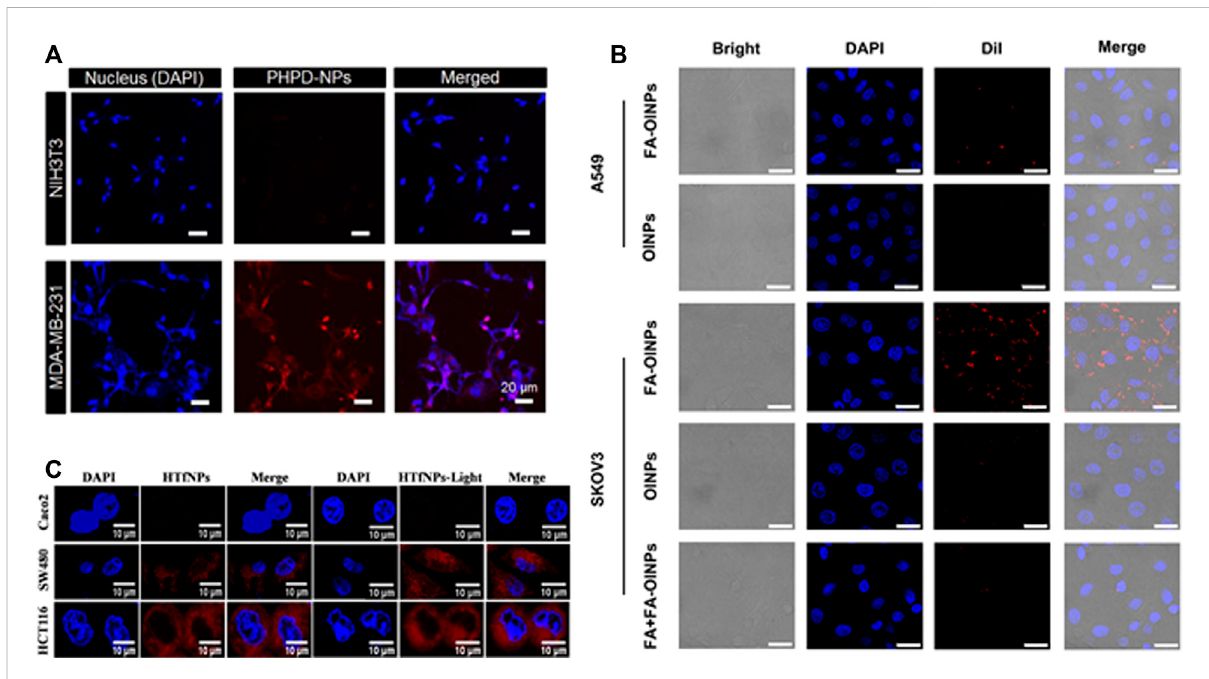
FIGURE 4 Schematic illustrations of confocal laser scanning microscopy images of different types of nanoparticles and their targeting ef fi ciency with differentreceptors. (A) CD44receptor — reprintedwithpermissionfromreference(Hanetal.,2016),Copyright2016,AmericanChemicalSociety; (B) Folate receptor — reprinted with permission from reference (Liu et al., 2019), Copyright 2019, American Chemical Society and (C) Transferrin receptor — reprinted with permission from reference (Sardoiwala et al., 2020), Copyright 2020, American Chemical